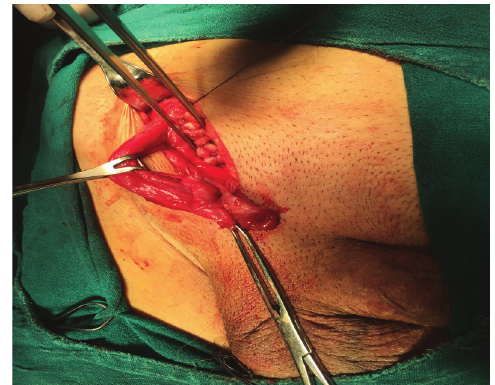
Figure 2: Thickened direct hernia sac present medial to the cord structure.